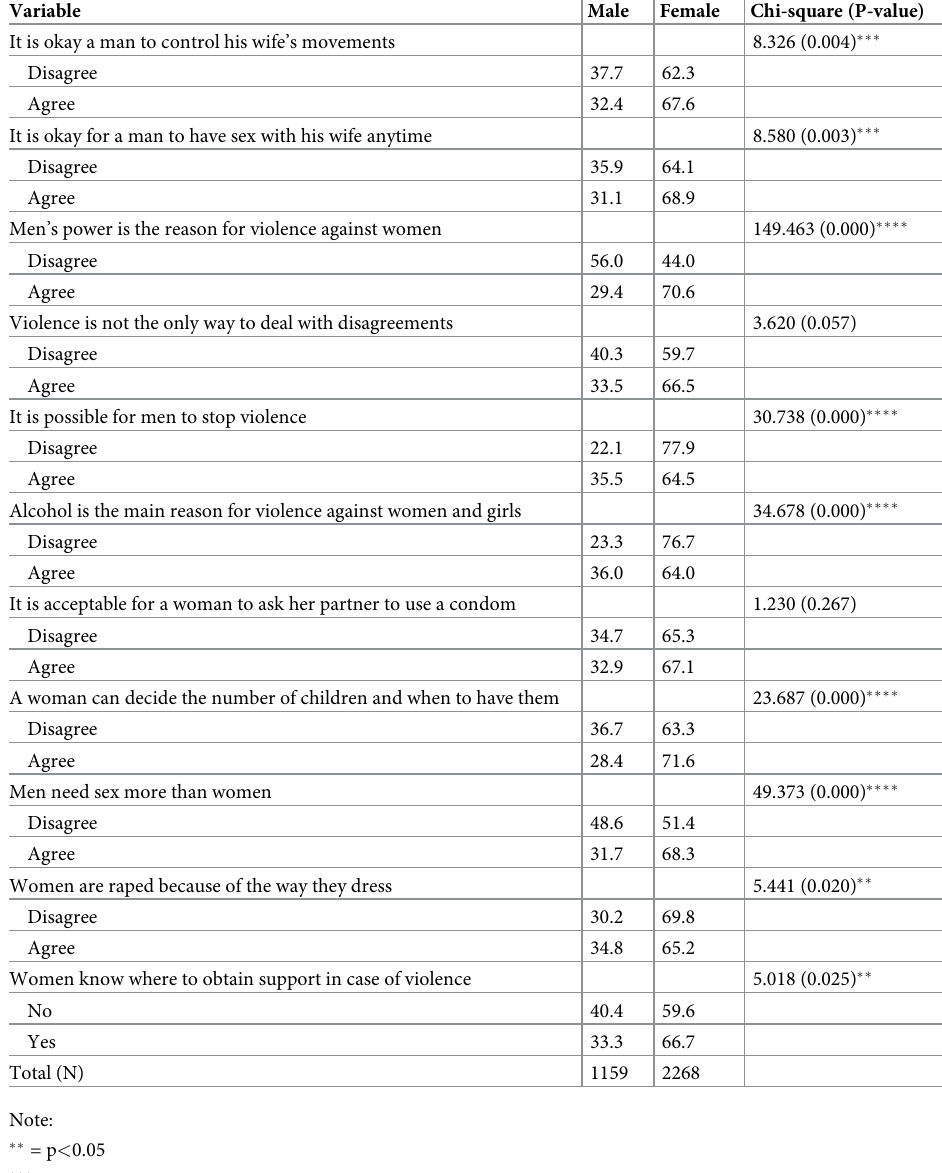
Table 2. Distribution of respondents by gender and attitudes towards violence against women. Variable Male Female Chi-square